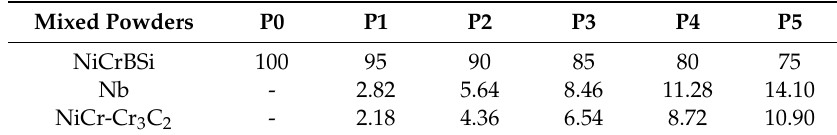
Table 2. The compositions of the powders used in this research (wt.%). Table 3. Welding